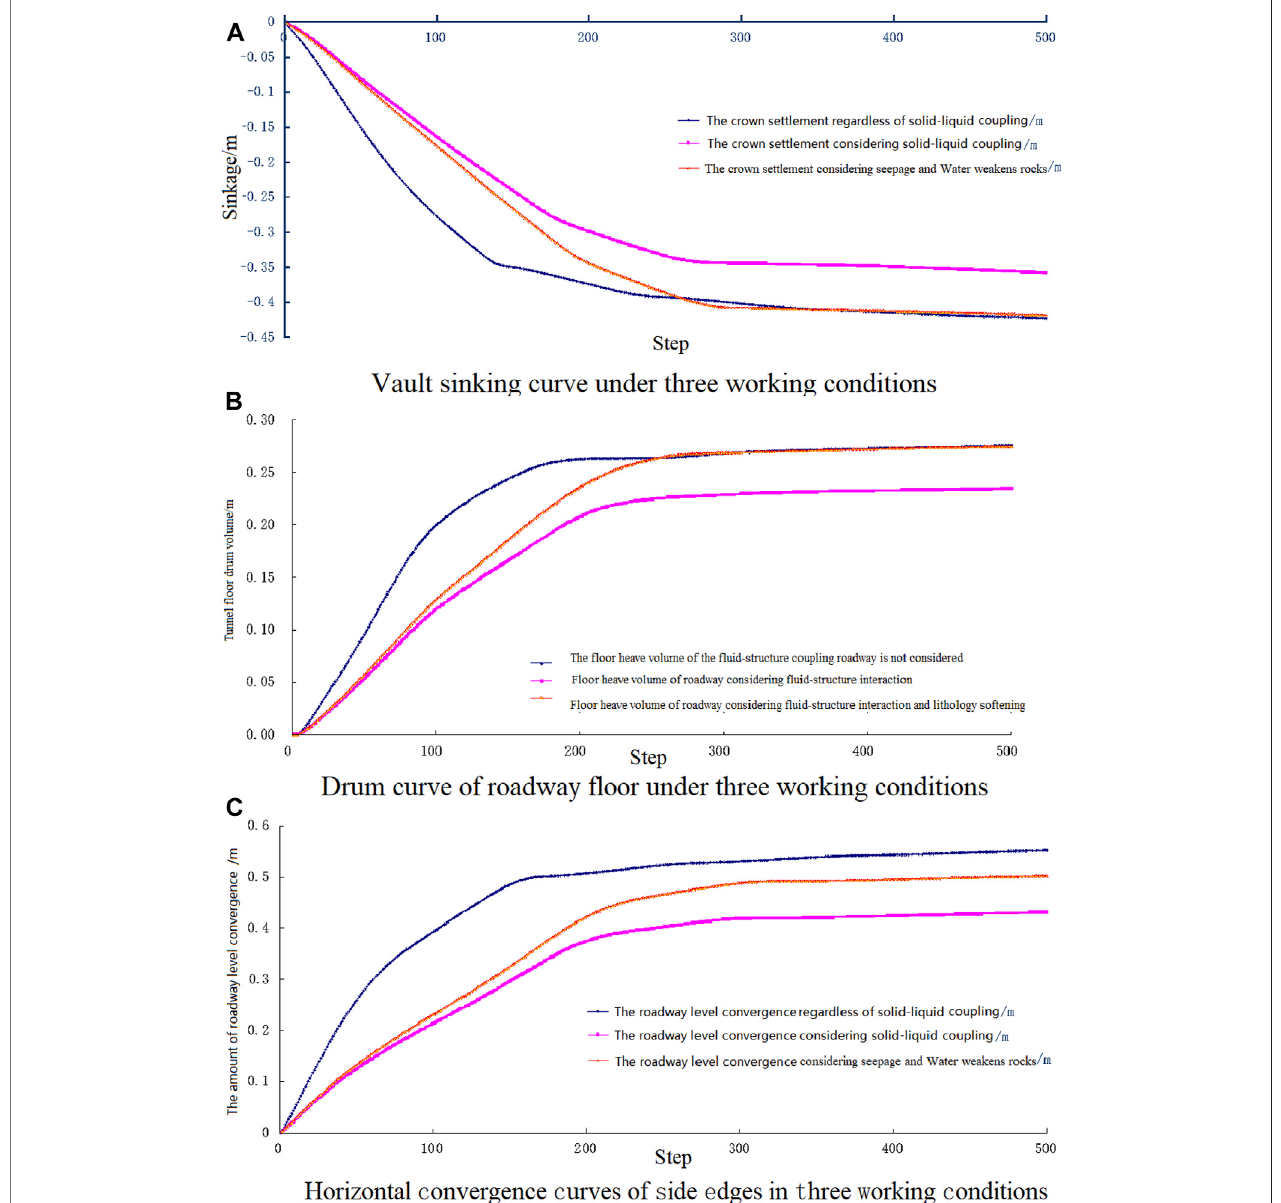
FIGURE 6 | Displacement curve in a different position. (A) Vault sinking curve under three working conditions. (B) Drum curve of the roadway fl oor under three working conditions. (C) Horizontal convergence curves of side edges in three working conditions.